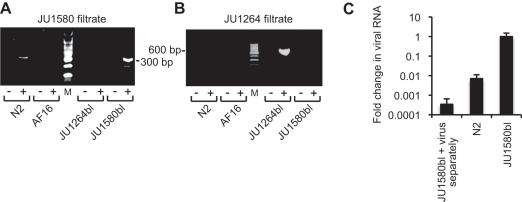
Specificity of infection by the Orsay and Santeuil viruses.(A) Specificity of infection by the Orsay virus. Each Caenorhabditis strain (name indicated below the gel) was mock-infected (−) or infected with a virus filtrate (+). RT-PCR on cultures after 7 d at 23°C. See Figure S3 for corresponding morphological symptom scoring. (B) Specificity of infection by the Santeuil virus. RT-PCR results after 4 d at 23°C. (C) Quantitative variation in viral replication N2 versus JU1580. N2 and JU1580 were tested by qRT-PCR for infection with Orsay virus extract (n = 10 independent replicates for each strain). By conventional RT-PCR assay, Orsay virus infection of N2 yielded positive bands in 3 out of 10 replicate infections whereas 7 out of 10 replicate infections of JU1580bl were positive in these conditions. Control RNA (n = 6) was extracted from JU1580bl animals grown in parallel without virus filtrate, and to which filtrate was added at the time of sample collection. RNA levels were normalized to ama-1 and shown as average fold-change relative to JU1580bl. Error bars represent SEM.